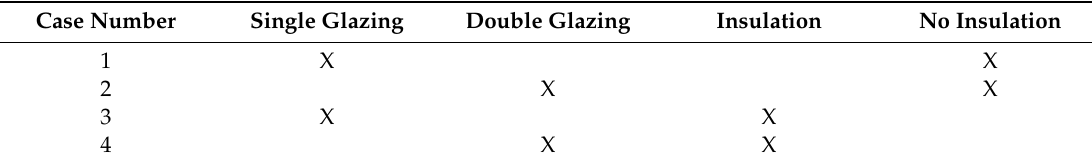
Table 1. Summary of case